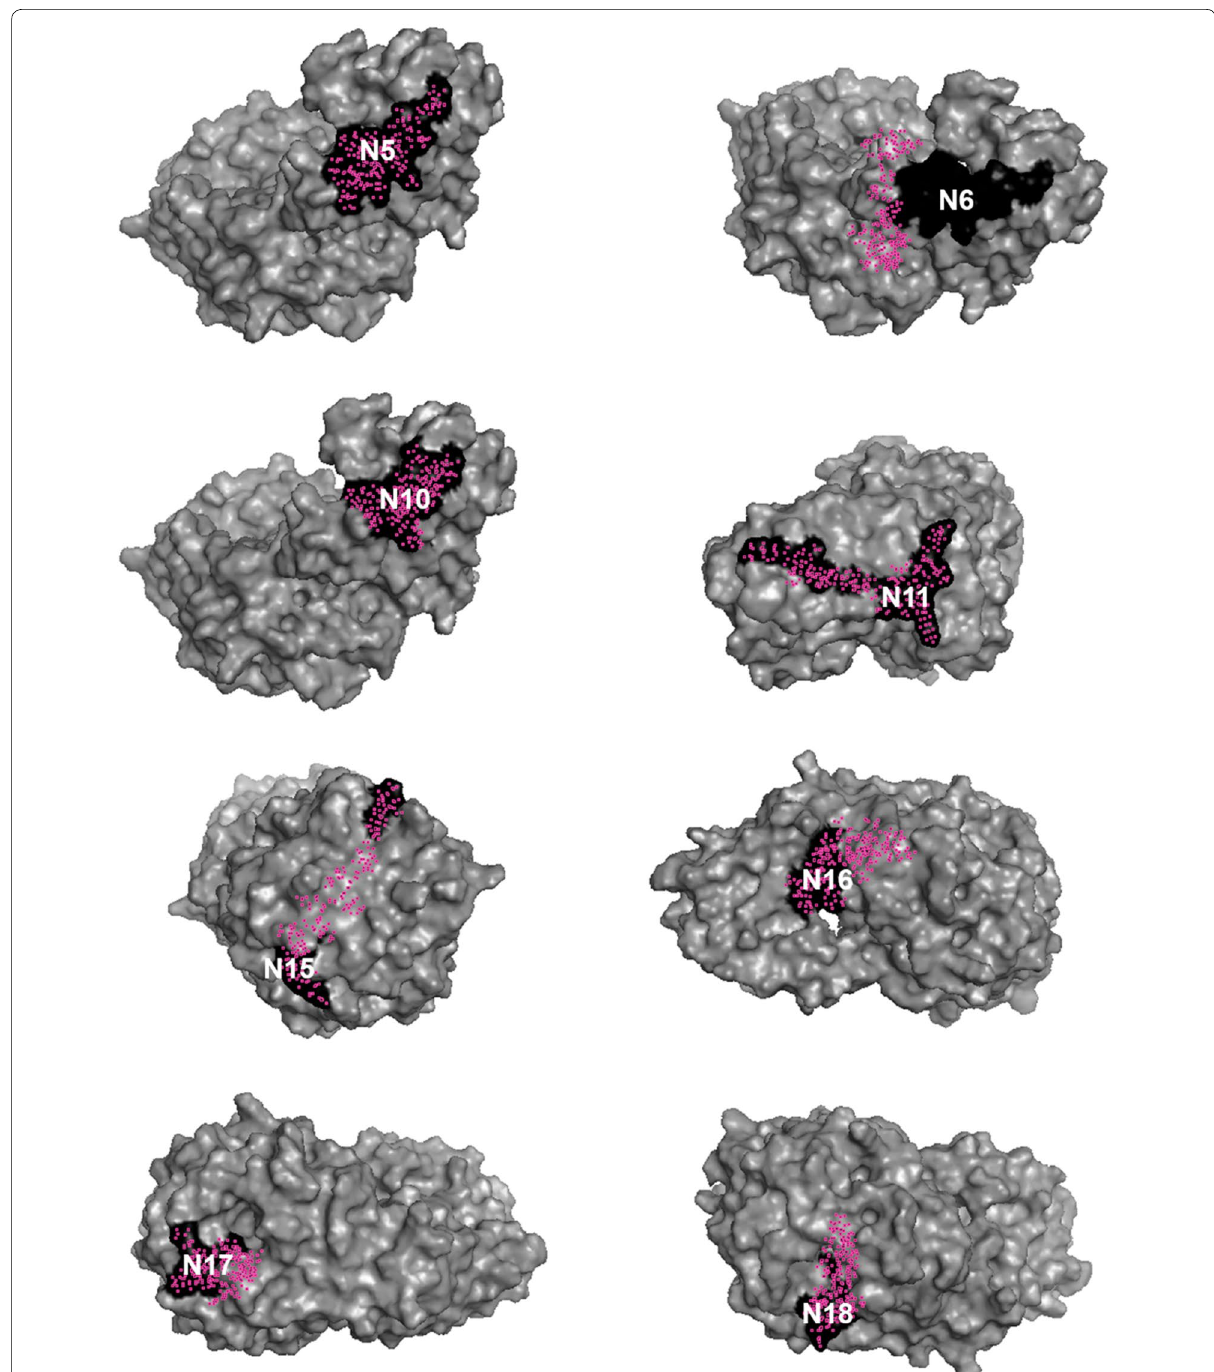
Fig. 3 Neuraminidase peptides. N5, N6, N10, N11, N15, N16, N17 and N18 are schematically presented in black in the neuraminidase protein after its modeling. Brazil,